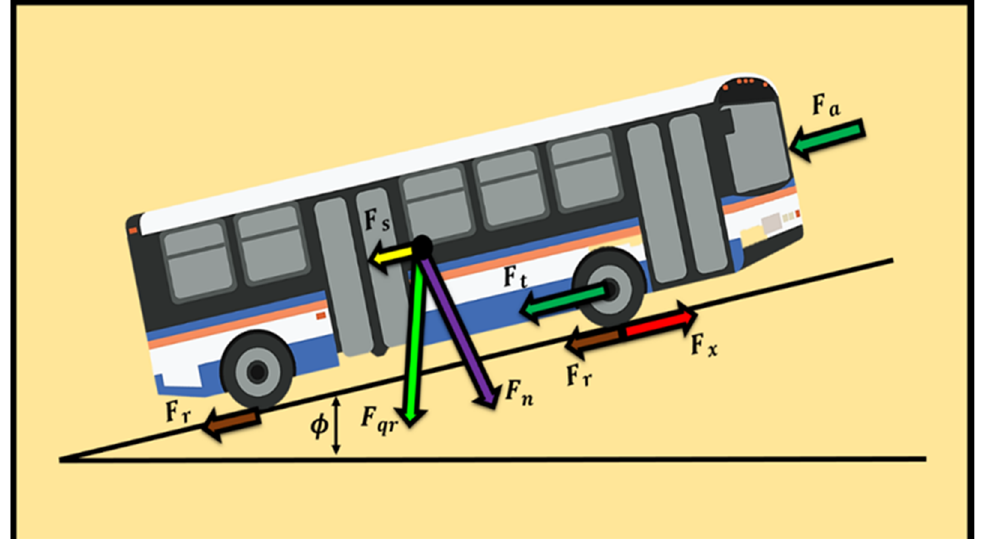
Figure 6. The total required driving force of a BEB.